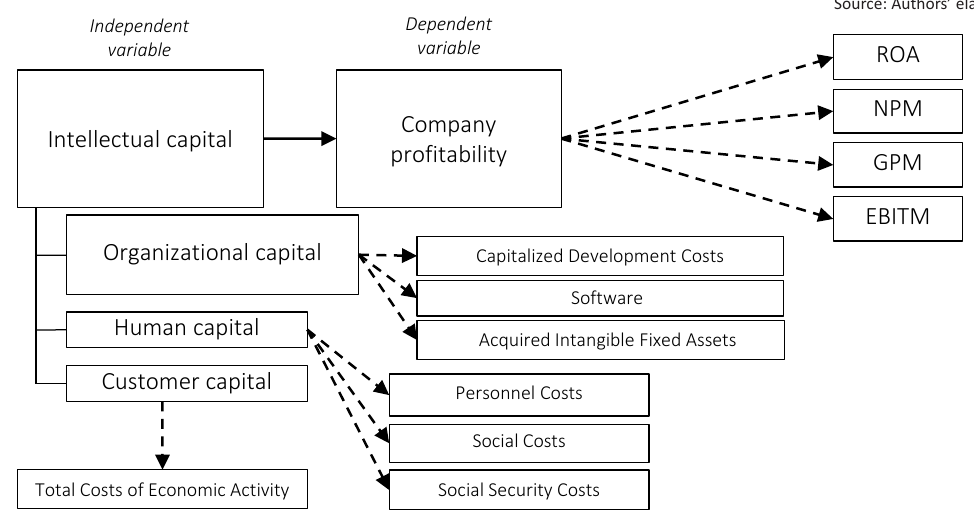
Figure 1. Conceptual framework